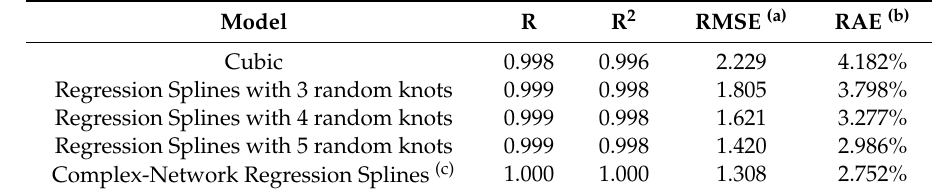
Table 2. Comparison between polynomial cubic and regression splines fitting curves with a complex network defined spline regression model-based the community detection proposed in this